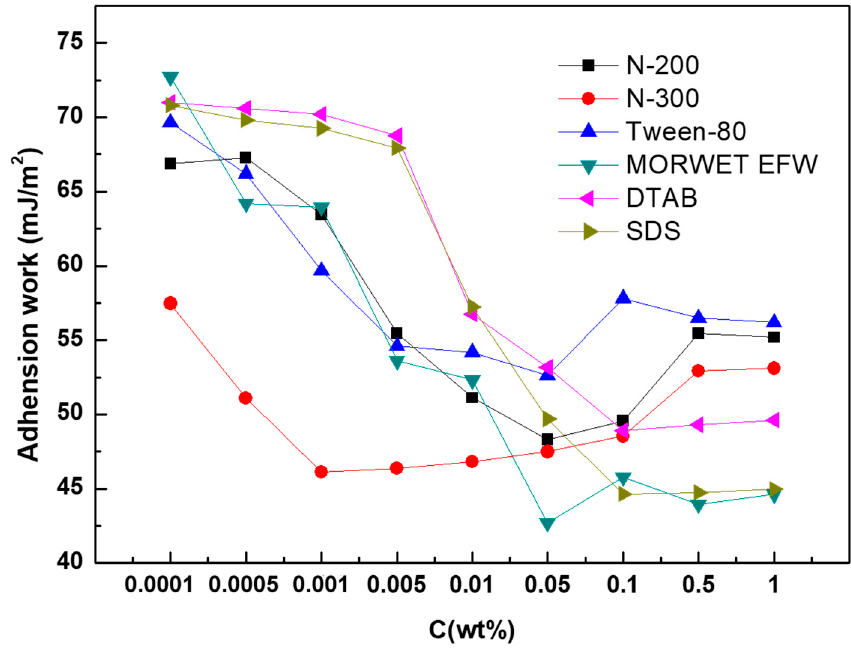
Figure 10. Dependence of the adhesion work of aqueous surfactant solutions on tea leaf surfaces.